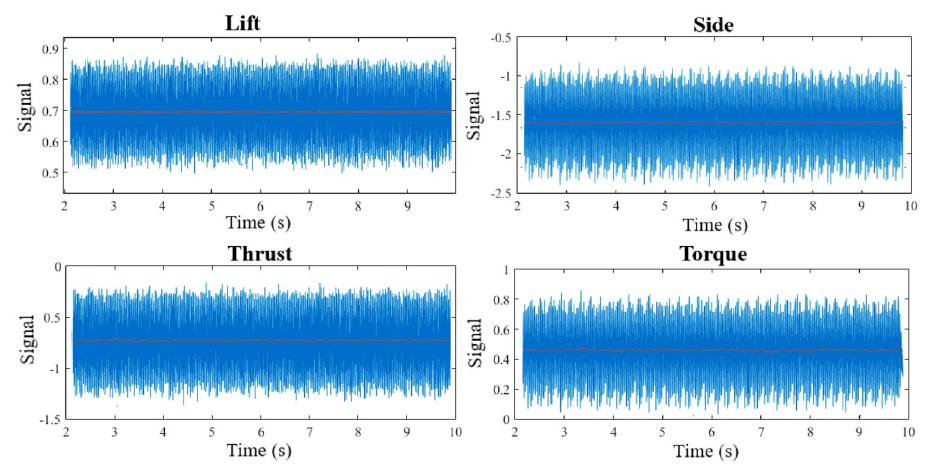
Figure 5. Output signals of force and torque sensors, and their filtered data.